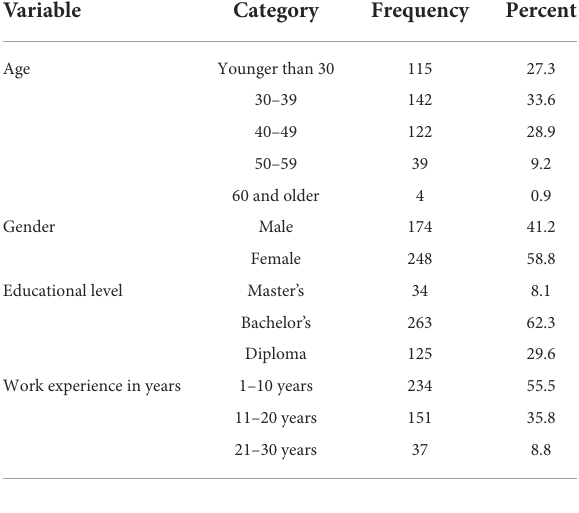
TABLE 1 Socio-demographic characteristics of respondents ( N = 422). Variable